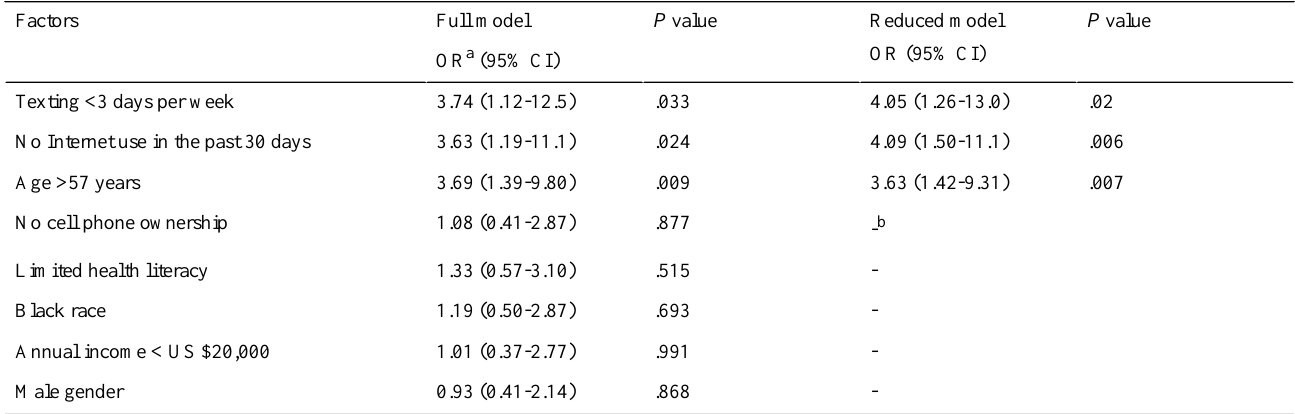
Table 4. Odds of needing assistance to complete the mPATH mHealth program by sociodemographic